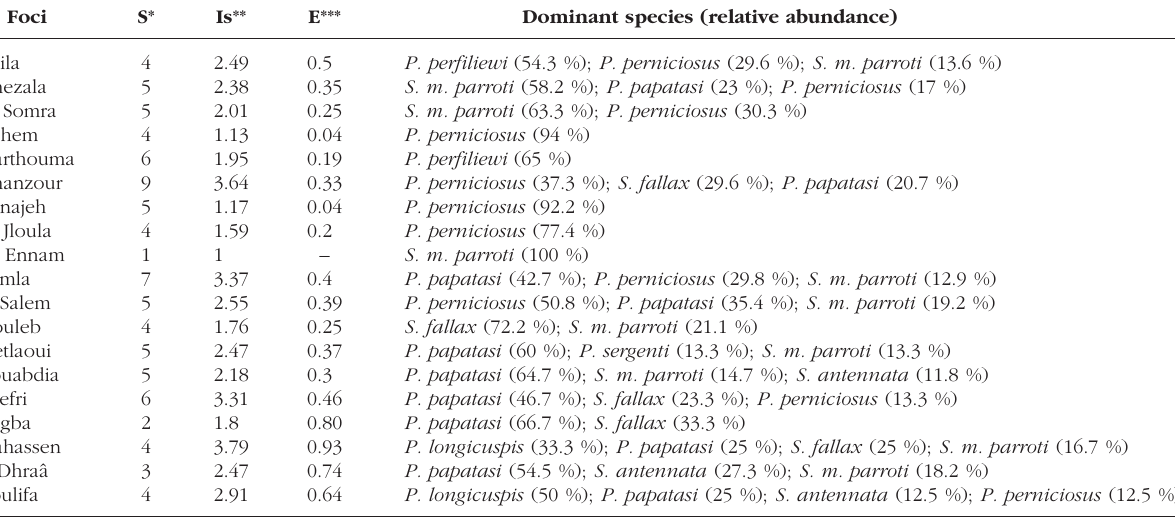
Foci S* Is** E*** Dominant species (relative abundance) Jmila